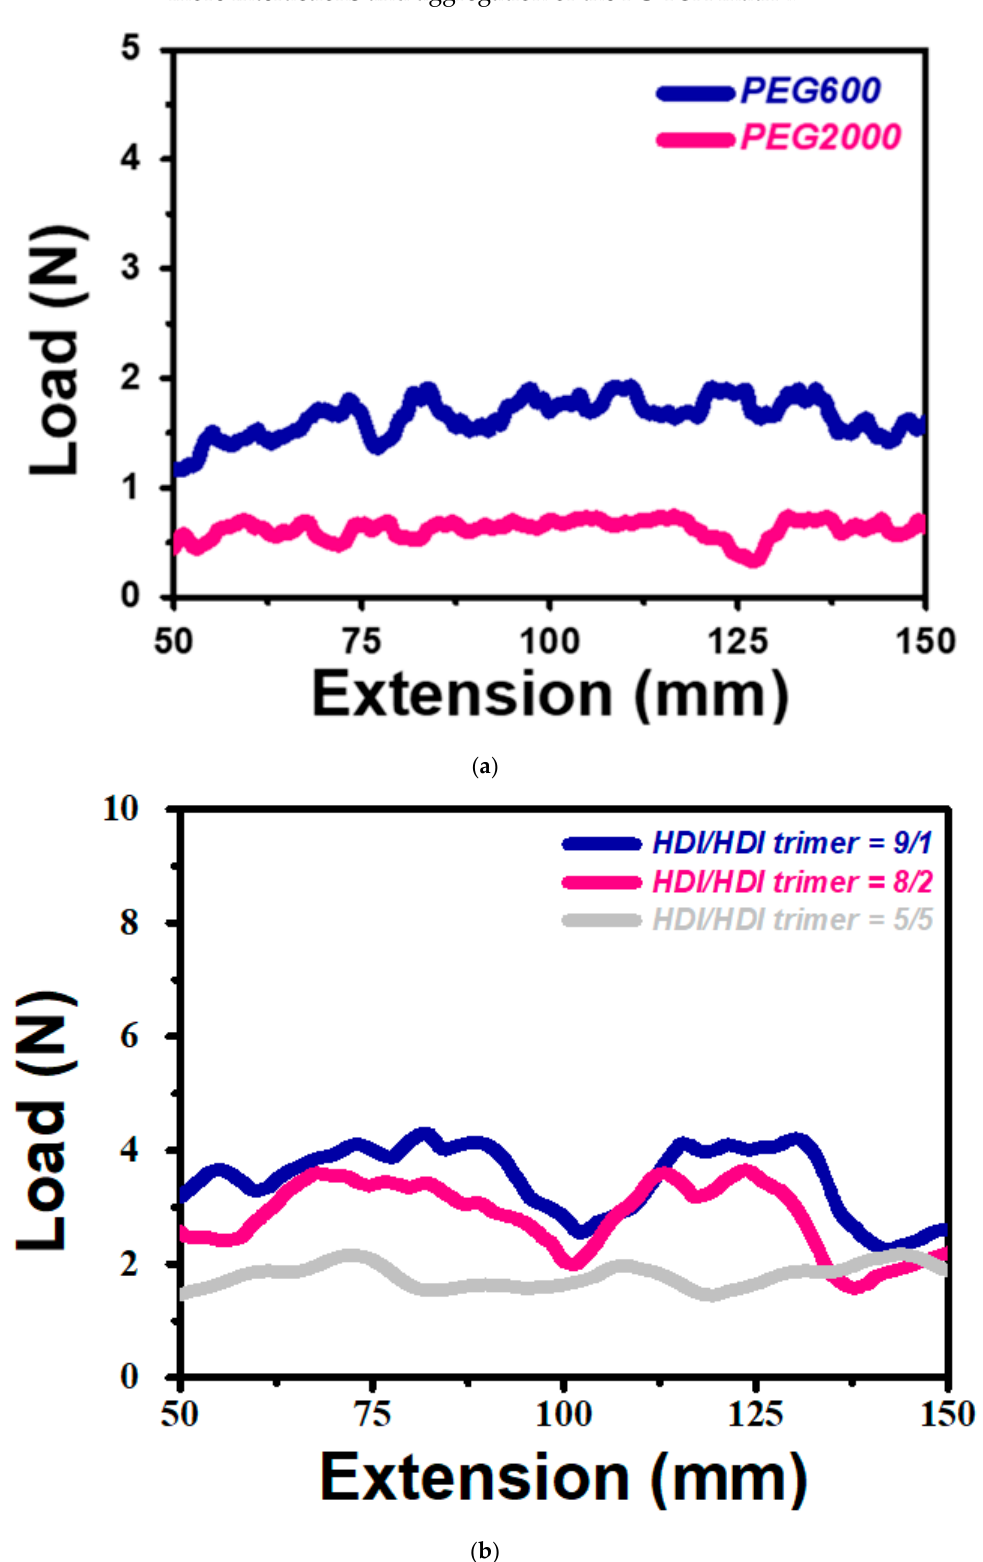
Figure 2. ( a ) 180° peel strength patterns of PU-PAS as a function of PEG MW and ( b ) bonding Figure 2. ( a ) 180 ◦ peel strength patterns of PU-PAS as a function of PEG MW and ( b ) bonding strength patterns between strength patterns between PU-PSA and glass-adherend by different HDI/HDI trimer ratios. PU-PSA and glass-adherend by different HDI/HDI trimer